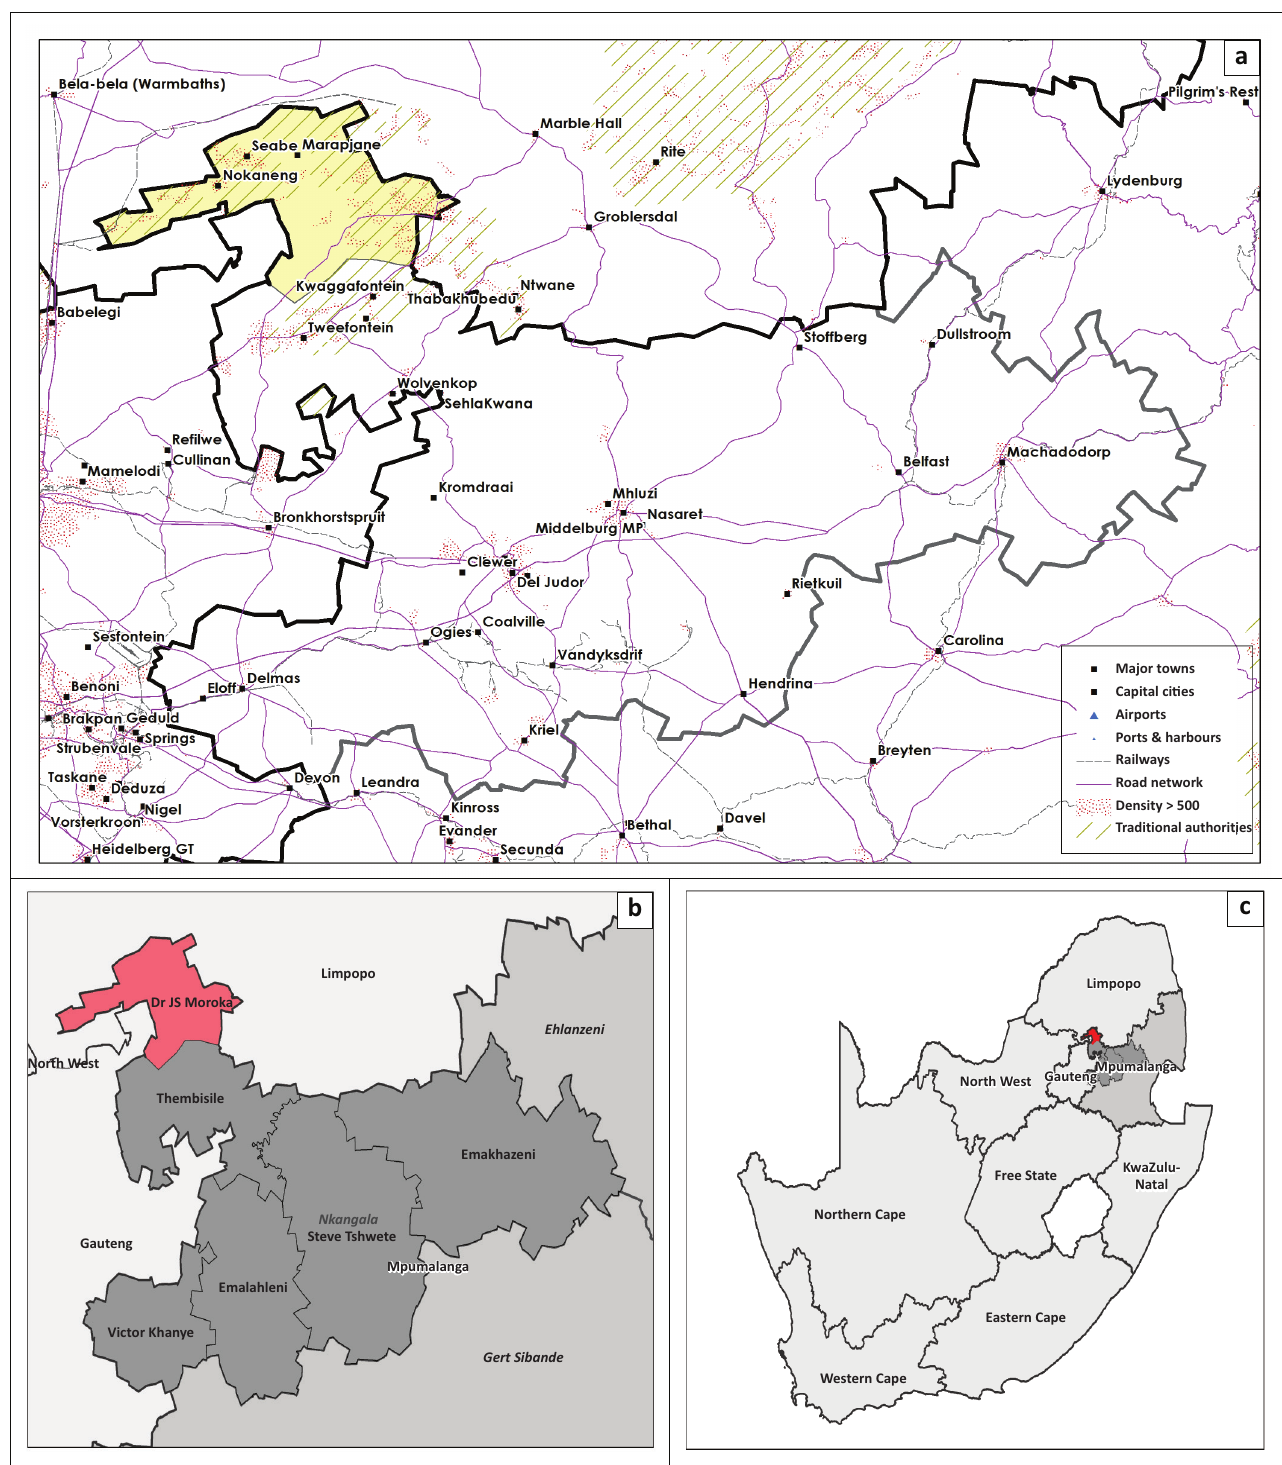
FIGURE 2: Map of the study area and its neighbourhoods.